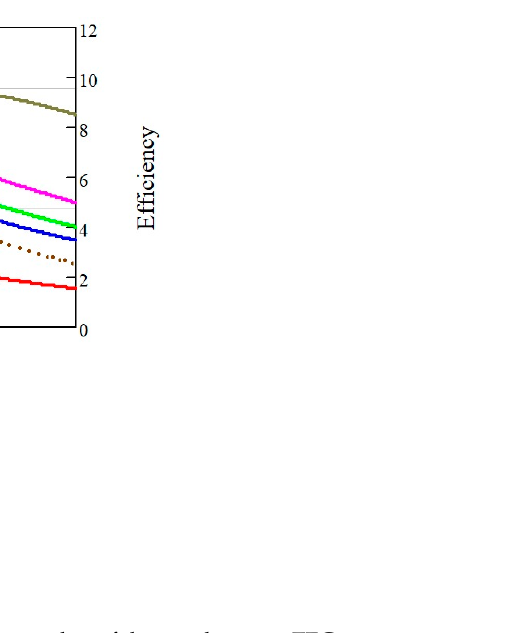
Figure 9. The relationship between load resistance ratio, TEG system power output, and thermoe- lectric efficiency.